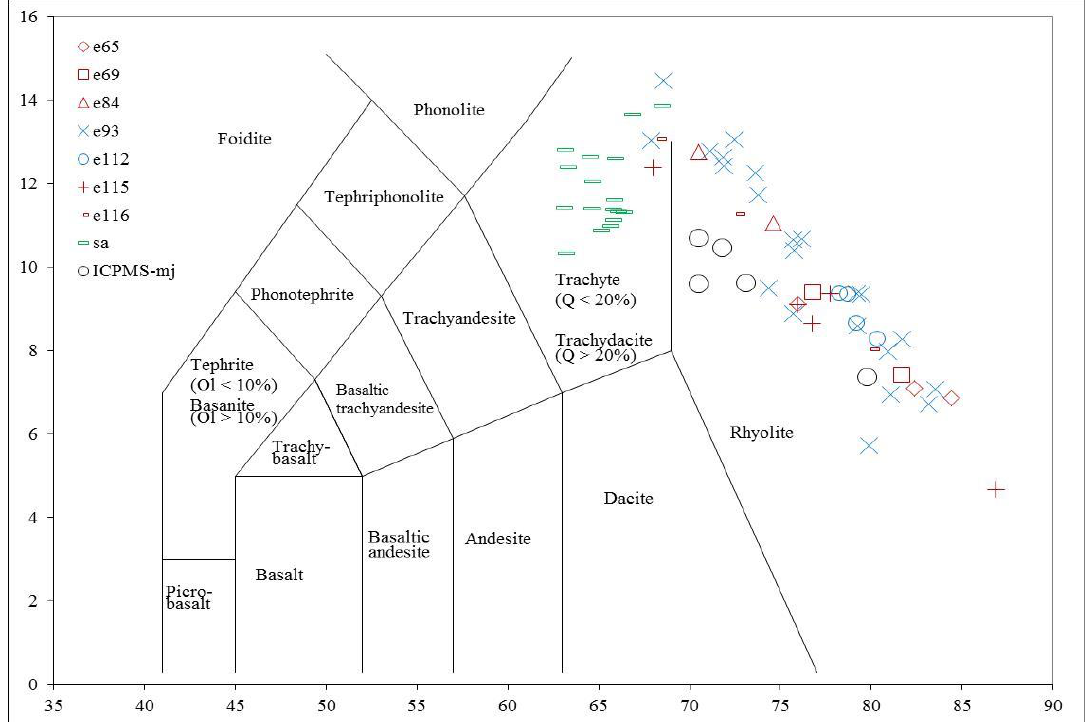
Figure 5. SiO 2 vs. total alkali (TAS) plot shows the shard chemistry. E- series samples are mainly in the rhyolite region with relatively high total alkali, and the SiO 2 increasing pattern might be caused by the silicification of the tuff in the diagenesis. The sample sa3 is a different volcanic unit. The ICP-MS whole-rock major data show as black circles.